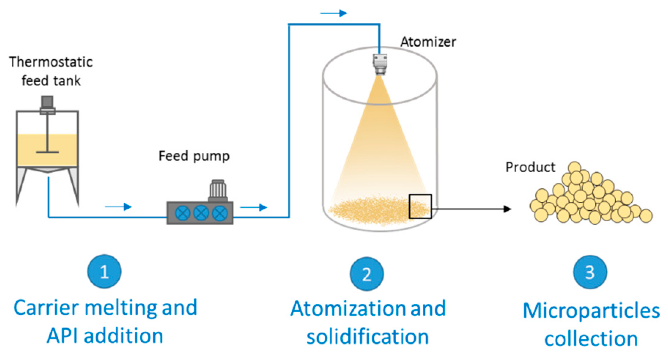
Figure 1. Scheme of a general spray congealing apparatus with the different steps for the production of of microparticles.